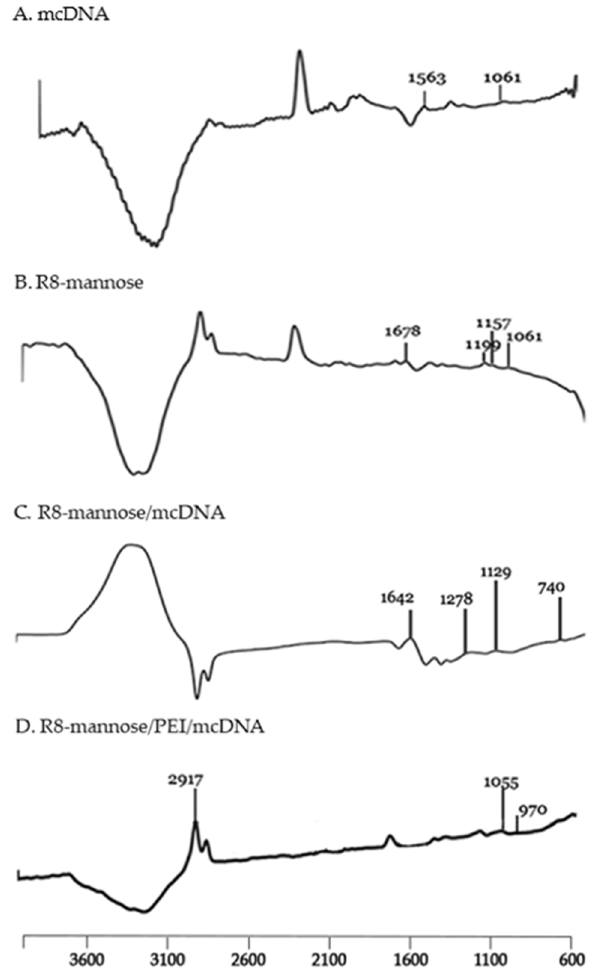
Figure 3. FTIR spectra (absorbance versus wavenumber) of mcDNA ( A ), R8-mannose ( B ), R8-mannose/mcDNA ( C ), and R8-mannose/PEI/mcDNA ( D ) samples.